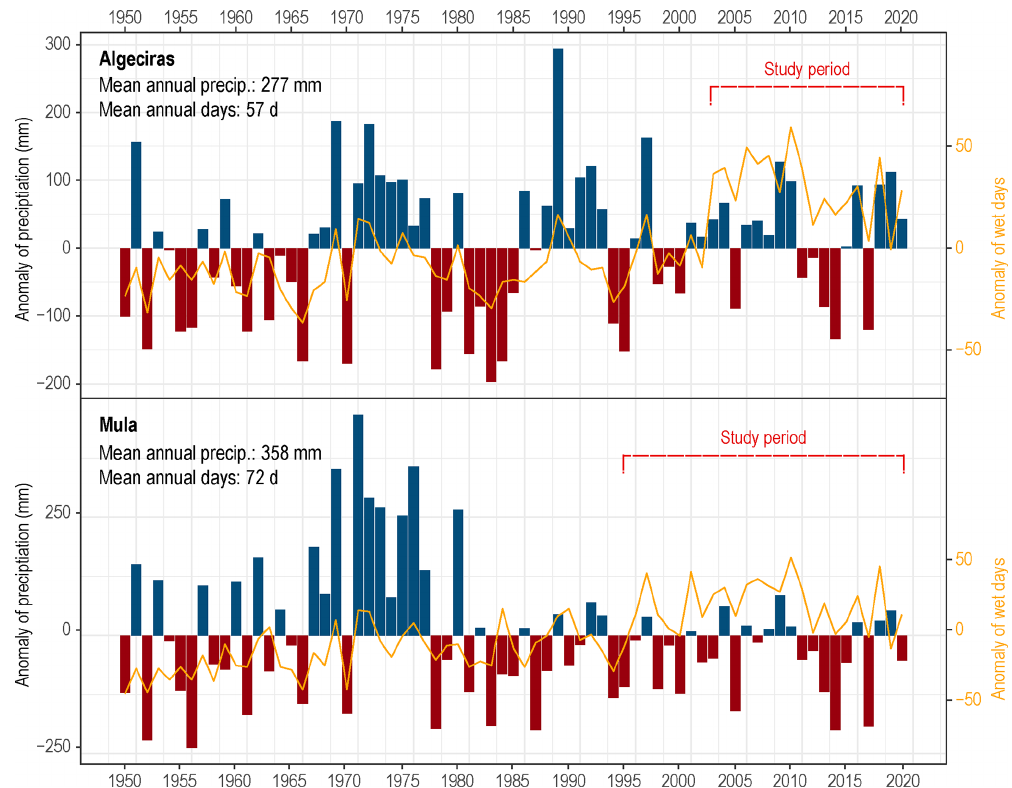
Figure 4. Annual precipitation anomalies (bars) and annual anomaly of the number of wet days ( P > 0) (lines). The period 1950–2020 was used as the base. Dashed lines indicate the period of data used for the analysis, coinciding with flow data availability. Table 2. Monthly percentage of non-contributing REs (rainfall events producing zero or negative (cid:49)Q)